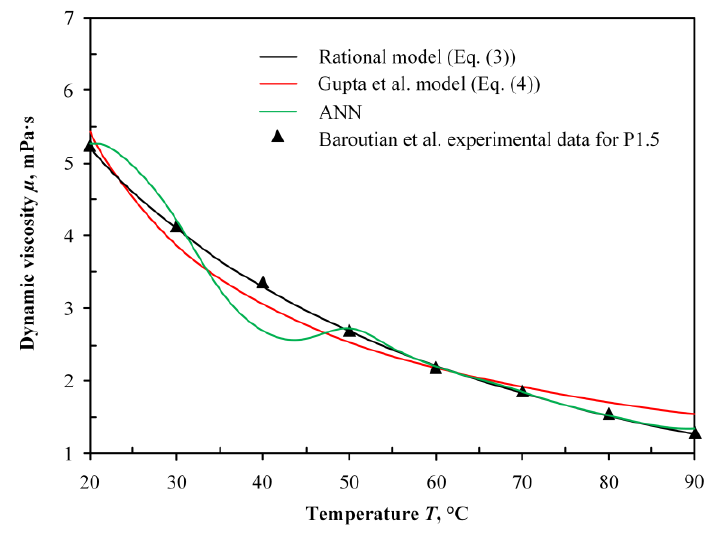
Fig. 4. Variation in dynamic viscosity of P1.5 vs. temperature. T ABLE 4. V ISCOSITY D ATA OF B LENDS M EASURED BY N OGUEIRA ET AL . [25], R ELATIVE E RRORS , AND R EGRESSION P